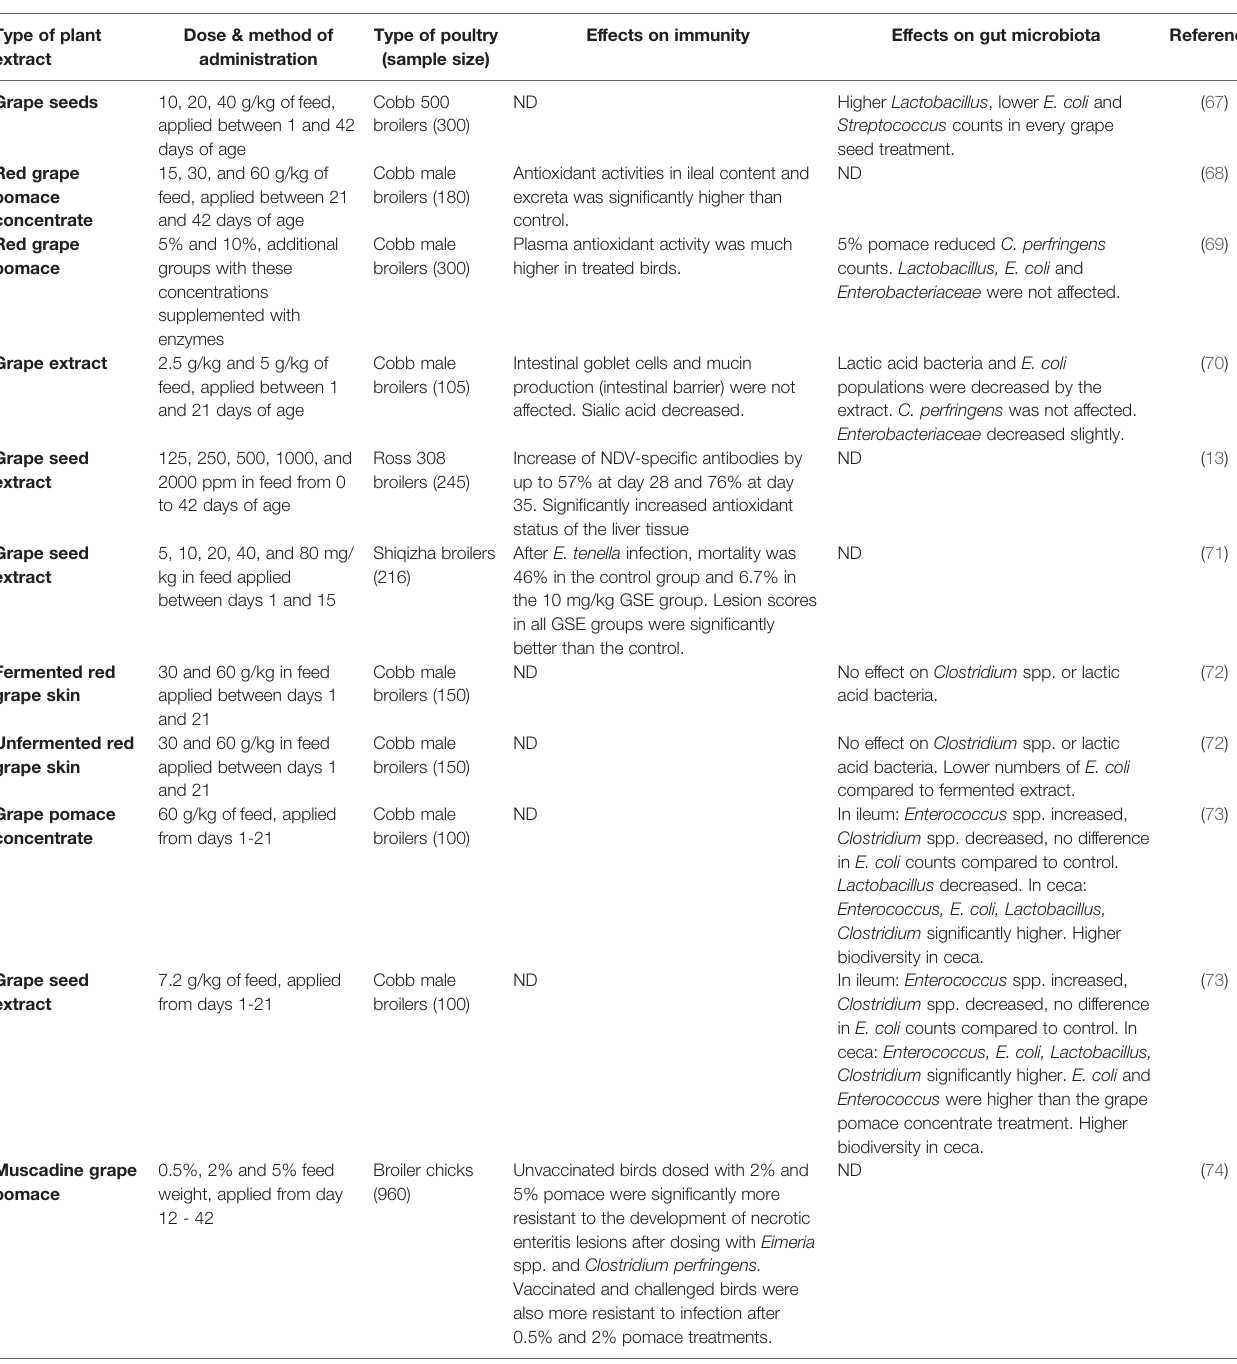
TABLE 4 | A comparison of in vivo feeding studies of grape byproducts and extracts in poultry, highlighting signi fi cant effects on the immune system and gut microbiota in live